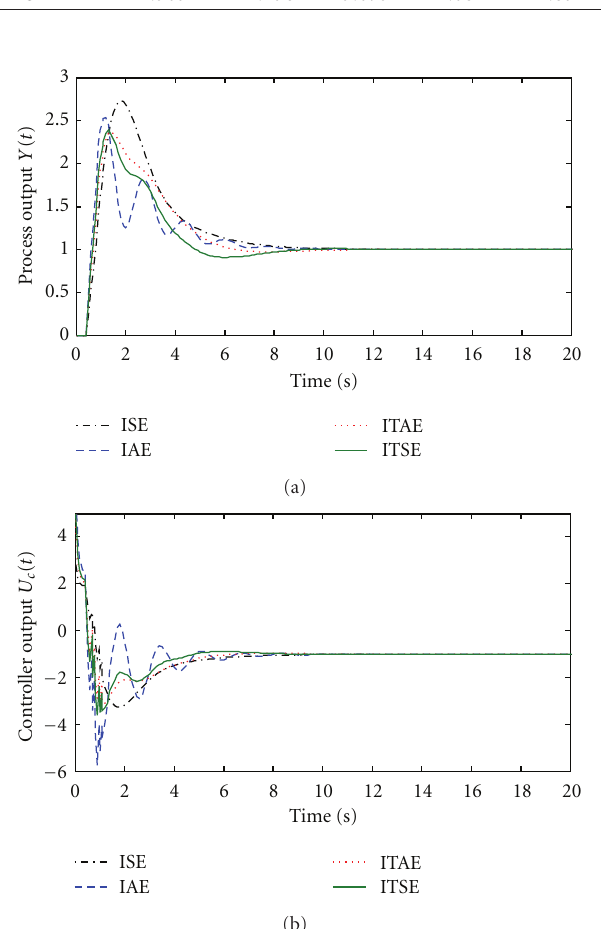
Figure 8: PID controller performance for Example 1, (a) process output, (b) controller output.